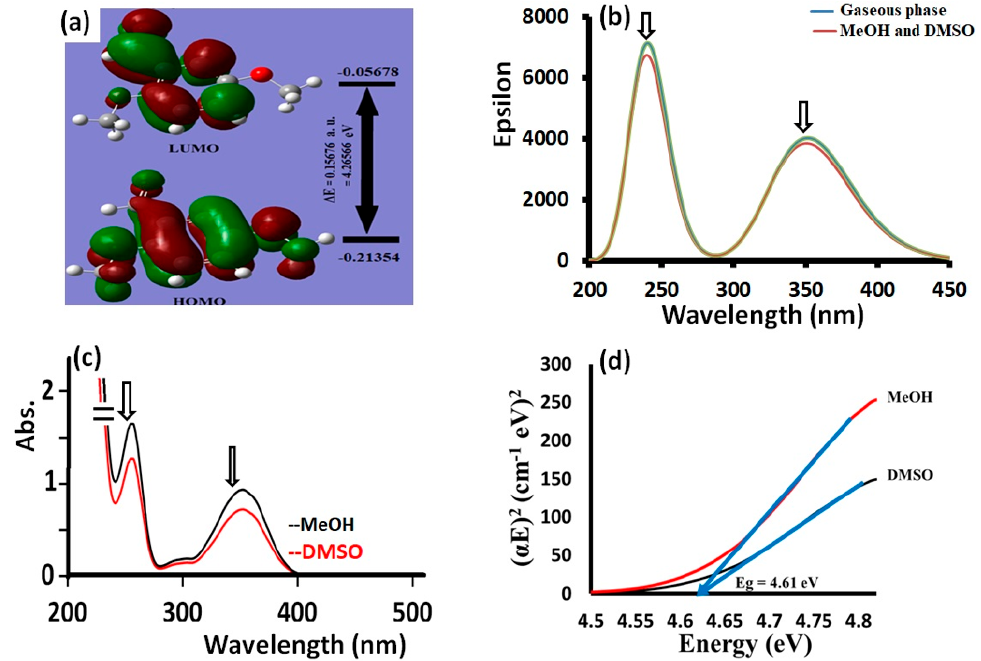
Figure 8. ( a ) HOMO/LUMO shapes and energy diagram. ( b ) TD-DFT. ( c ) Experimental UV spectra, and ( d ) optical energy band gap ( E g ) of the 2.2x10 -6 M of 2,5-dimethoxybenzaldehyde in MeOH and DMSO.